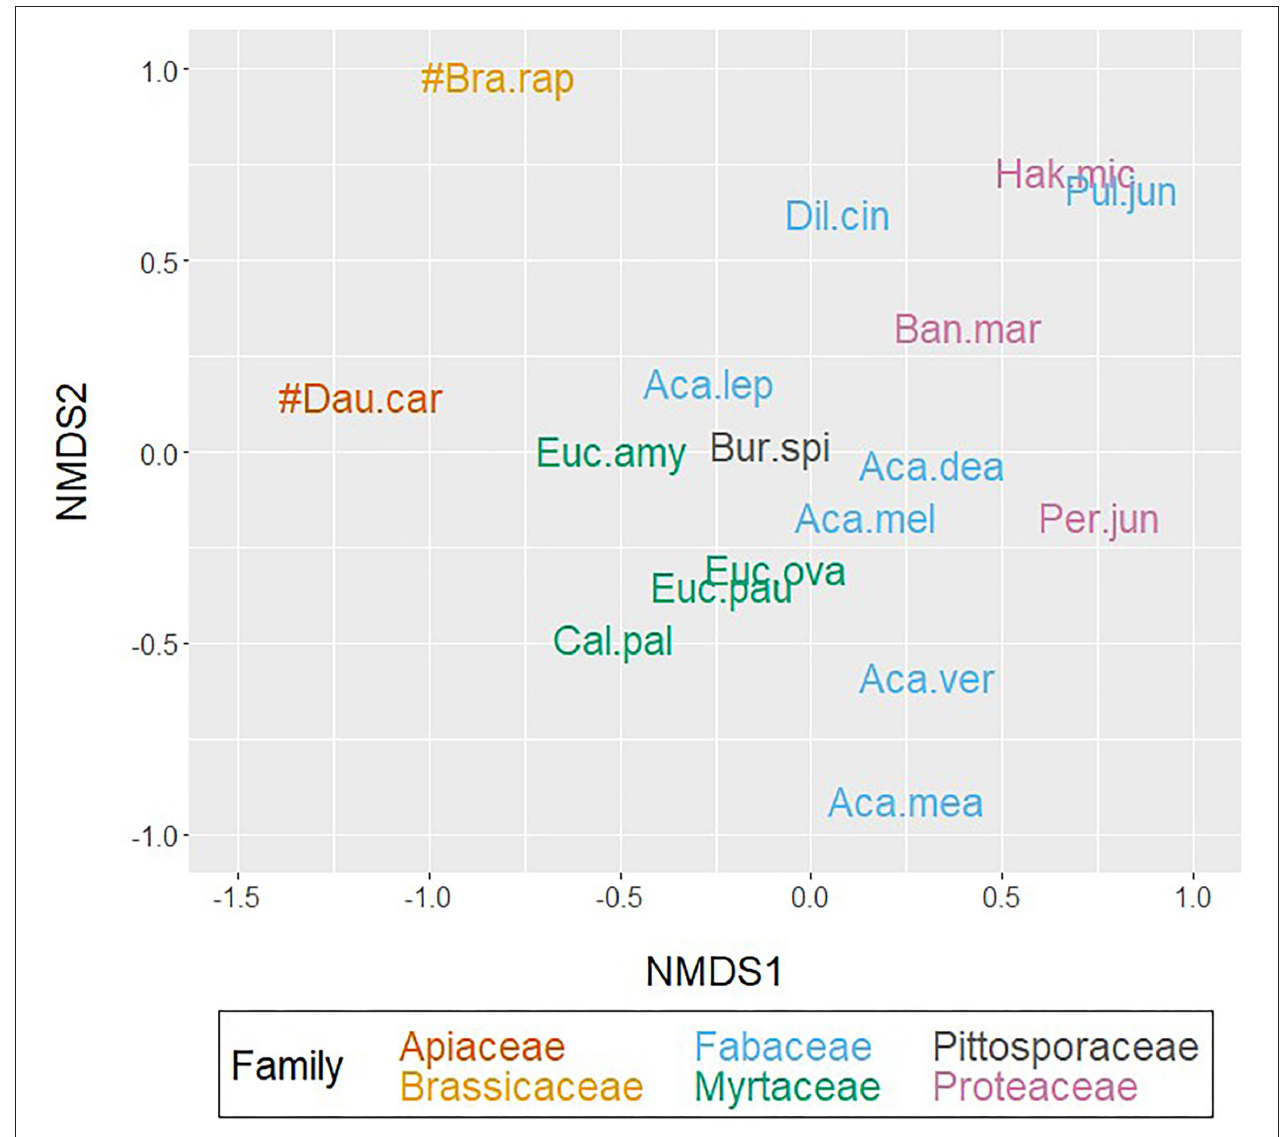
abbreviation keys, refer to Table 1 and Section Floral Scent Sampling and